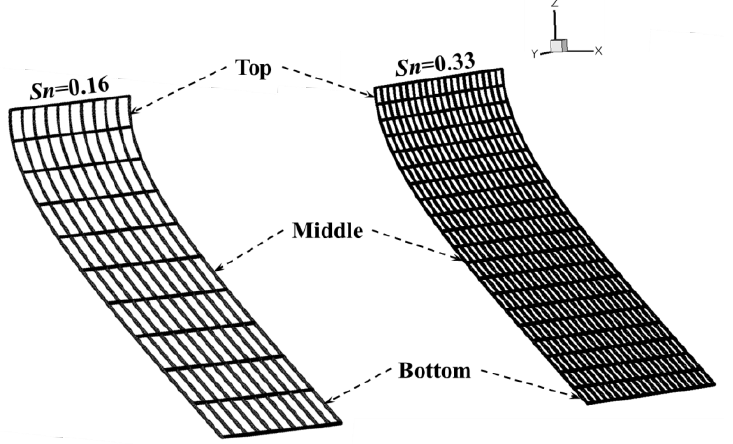
Figure 9. The selected sections on the net panels are used to monitor vortex formation behind vertical net twines. Here, these two deformed net panels are under a flow velocity of 0.75 m/s.